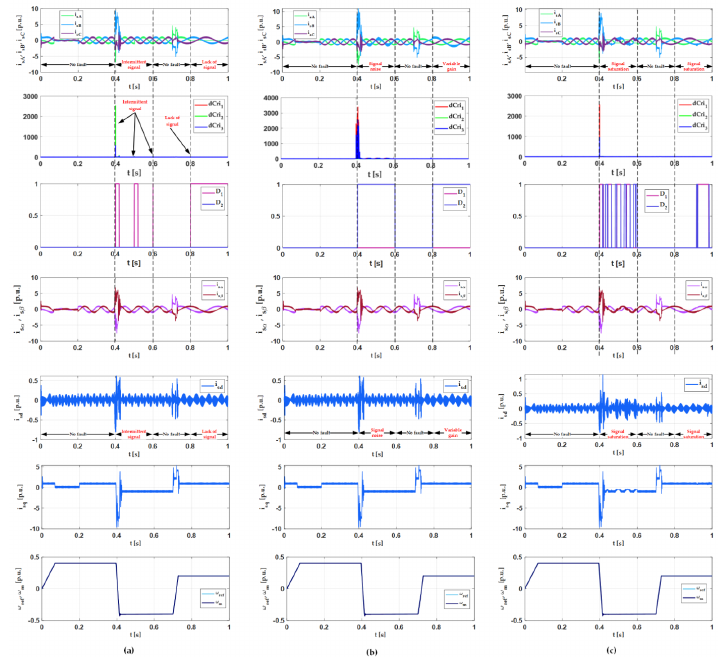
Figure 16. Transients of basic variables: phase currents, markers errors, detector responses, current components α , β , i sd , i sq current components and speed under lack of signal and intermittent signal in phase A ( a ), signal noise and variable gain ( b ), signal saturation ( c ), respectively.